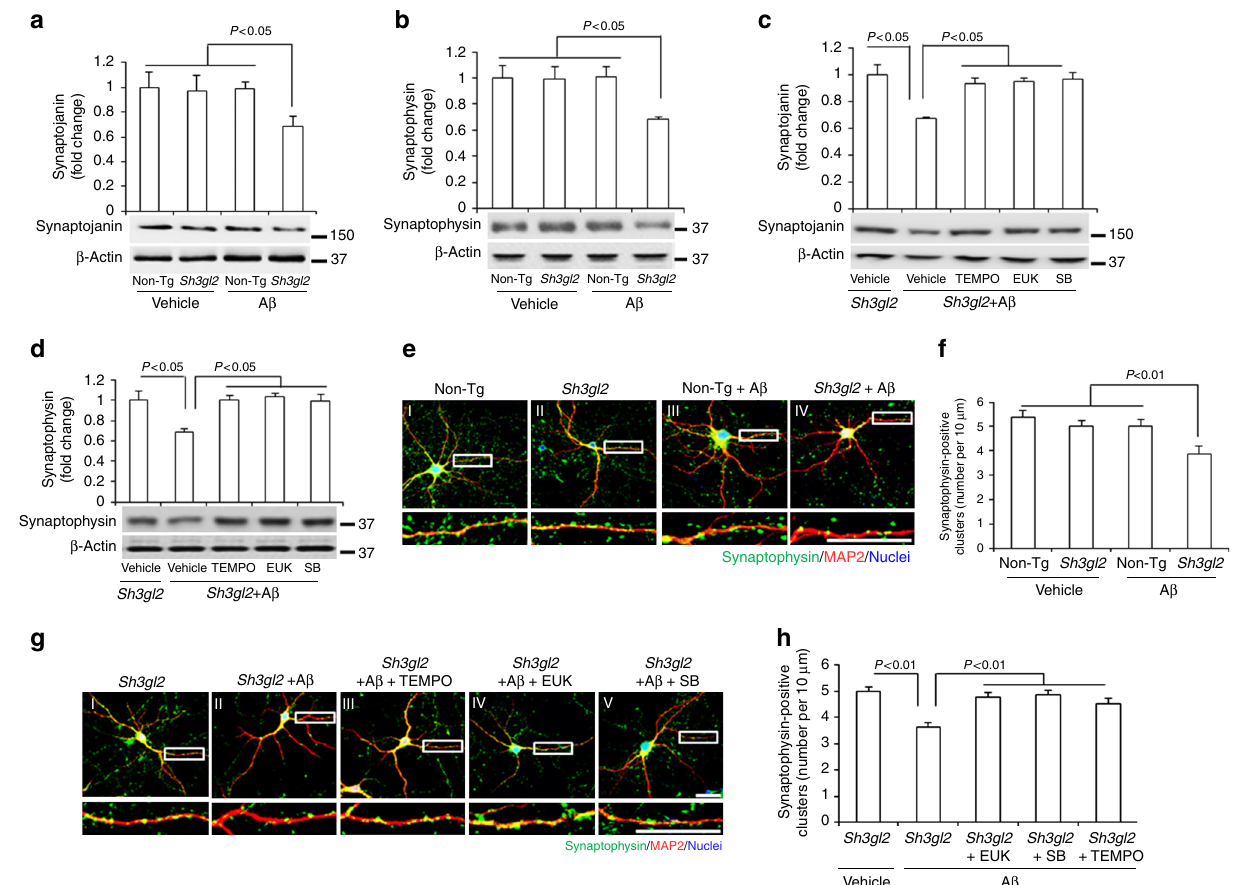
Fig. 6 Blocking EP-mediated oxidative stress and p38 activation rescued A β -induced synaptic loss. a , b Brain slices from 3-month-old non-Tg or Tg Sh3gl2 mice were perfused with A β (50 nM) for 2 h, and then subjected to immunoblotting analysis for synaptojanin ( a ) and synaptophysin ( b ) in the indicated groups of brain slices. β -Actin served as protein loading controls. The upper panel displays quanti fi cation of immunoreactive bands for the corresponding protein relative to β -actin. Data are expressed as fold change relative to the non-Tg vehicle control group. Data are shown as mean ± s.e.m., n = 3 per group (one-way ANOVA in a , b ). c , d The Tg Sh3gl2 brain slices from 3-month-old mice were perfused with A β (50 nM) for 2 h with/without pretreatment of 500 nM EUK-134 (EUK), 1 μ M SB203580 (SB), or 1 µ M MitoTEMPO (TEMPO) for 5 min. Immunoblotting for synaptojanin ( c ) and synaptophysin ( d ) in the indicated groups of brain slices. The upper panel displays the quanti fi cation of immunoreactive bands for the corresponding protein relative to β -actin. Data are expressed as fold change relative to Tg Sh3gl2 vehicle control group. Data are shown as mean ± s.e.m., n = 3 per group (one-way ANOVA in c , d ). Fourteen-day in vitro cultured cortical neurons, either non-Tg or Tg Sh3gl2 , were treated with 50 nM A β for 24 h, with or without 500 nM EUK-134, 1 μ M SB203580, or 1 μ M MitoTEMPO pretreatment for 1 h before the addition of A β . The numbers of synaptophysin-positive clusters were signi fi cantly decreased in A β -treated Tg Sh3gl2 neurons compared to vehicle-treated non-Tg neurons in e – h . Treatment with EUK-134, or SB203580, or MitoTEMPO, inhibited A β -induced synaptic loss in cultured EP overexpression neurons ( g , h ). Representative images for synaptophysin (green), MAP2 (red), and nuclei (blue) in the indicated groups of neurons are shown in e , g . Scale bars, 50 μ m. Quanti fi cations of synaptophysin-positive clusters per 10 μ m of dendrites are shown in f , h . Data are shown as mean ± s.e.m., n = 12 cells for each group (one-way ANOVA in f , h )